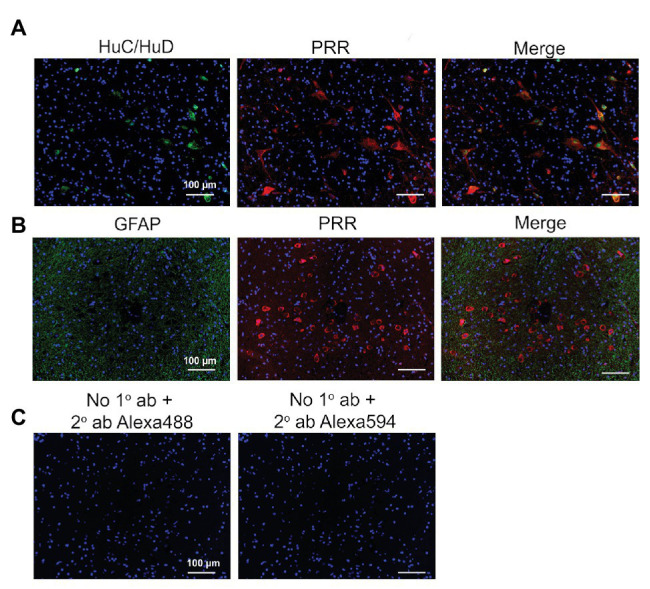
Expression of the PRR in RVLM neurons of the human brain. (A) RVLM brain tissues were immunolabeled for the PRR (red) and the neuronal marker HuC/HuD (green). (B) RVLM brain tissues were immunolabeled for the PRR (red) and the astrocyte marker glial fibrillary acidic protein (GFAP; green). (C) Sections processed without primary antibody but with Alexa 488 (green) or Alexa 594 (red) secondary antibody were used as negative controls. ab, antibody; 1°, primary; and 2°, secondary.